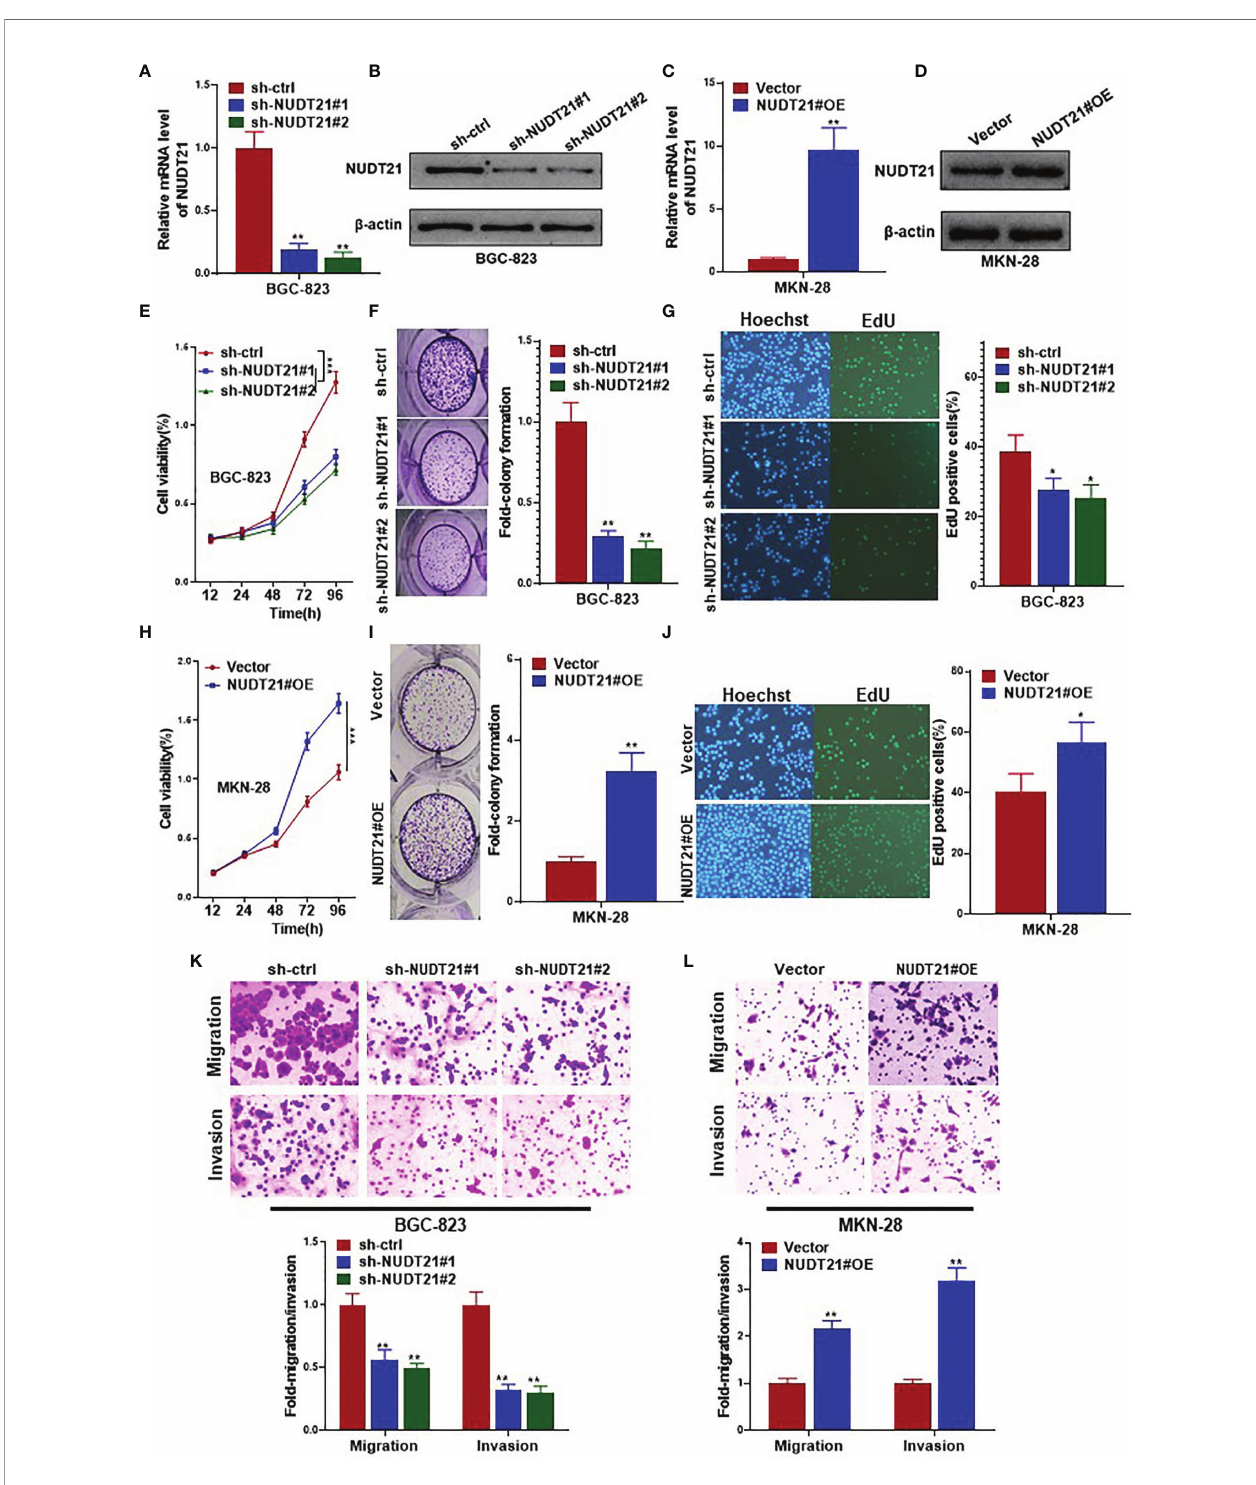
FIGURE 2 | NUDT21 stimulated cell proliferation, migration and invasion of human gastric cancer cells. BGC-823 cells were transfected with sh-NUDT21#1, sh-NUDT21#2 or sh-ctrl. MKN-28 cells were transfected with the NUDT21 overexpression plasmids (NUDT21#OE) and Vector control plasmids (Vector). (A, C) Relative mRNA levels of NUDT21 were examined by RT-qPCR. GAPDH was used as control. (B, D) Protein levels of NUDT21 were detected by western blot. b -Actin was used as control. (E, H) MTT assay was carried out to evaluate cell viability. (F, I) Cell colony formation assay. Cell colony numbers were calculated after 14 days. (G, J) EdU assay was performed to evaluate cell proliferation. (K, L) Cell migration and invasion assays were carried out to examine cell metastasis. * P < 0.05; ** P < 0.01; *** P <